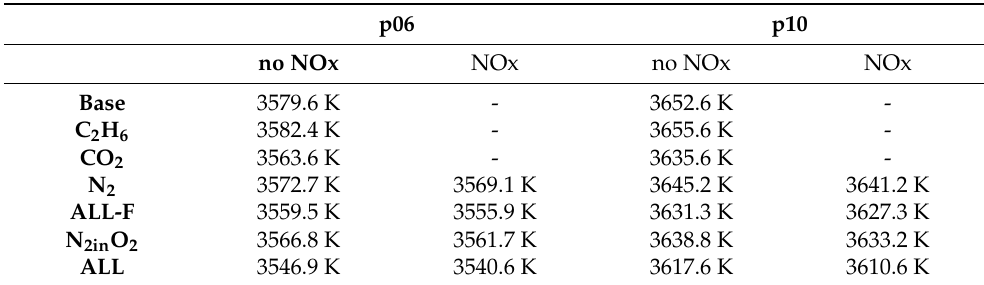
Table 7. Influence of the active NOx chemistry on the maximum flame temperature at stoichiometric mixture fraction for different impurities of the fuel and/or the oxidizer at pressures of 6 and 10 MPa. (counter flow diffusion